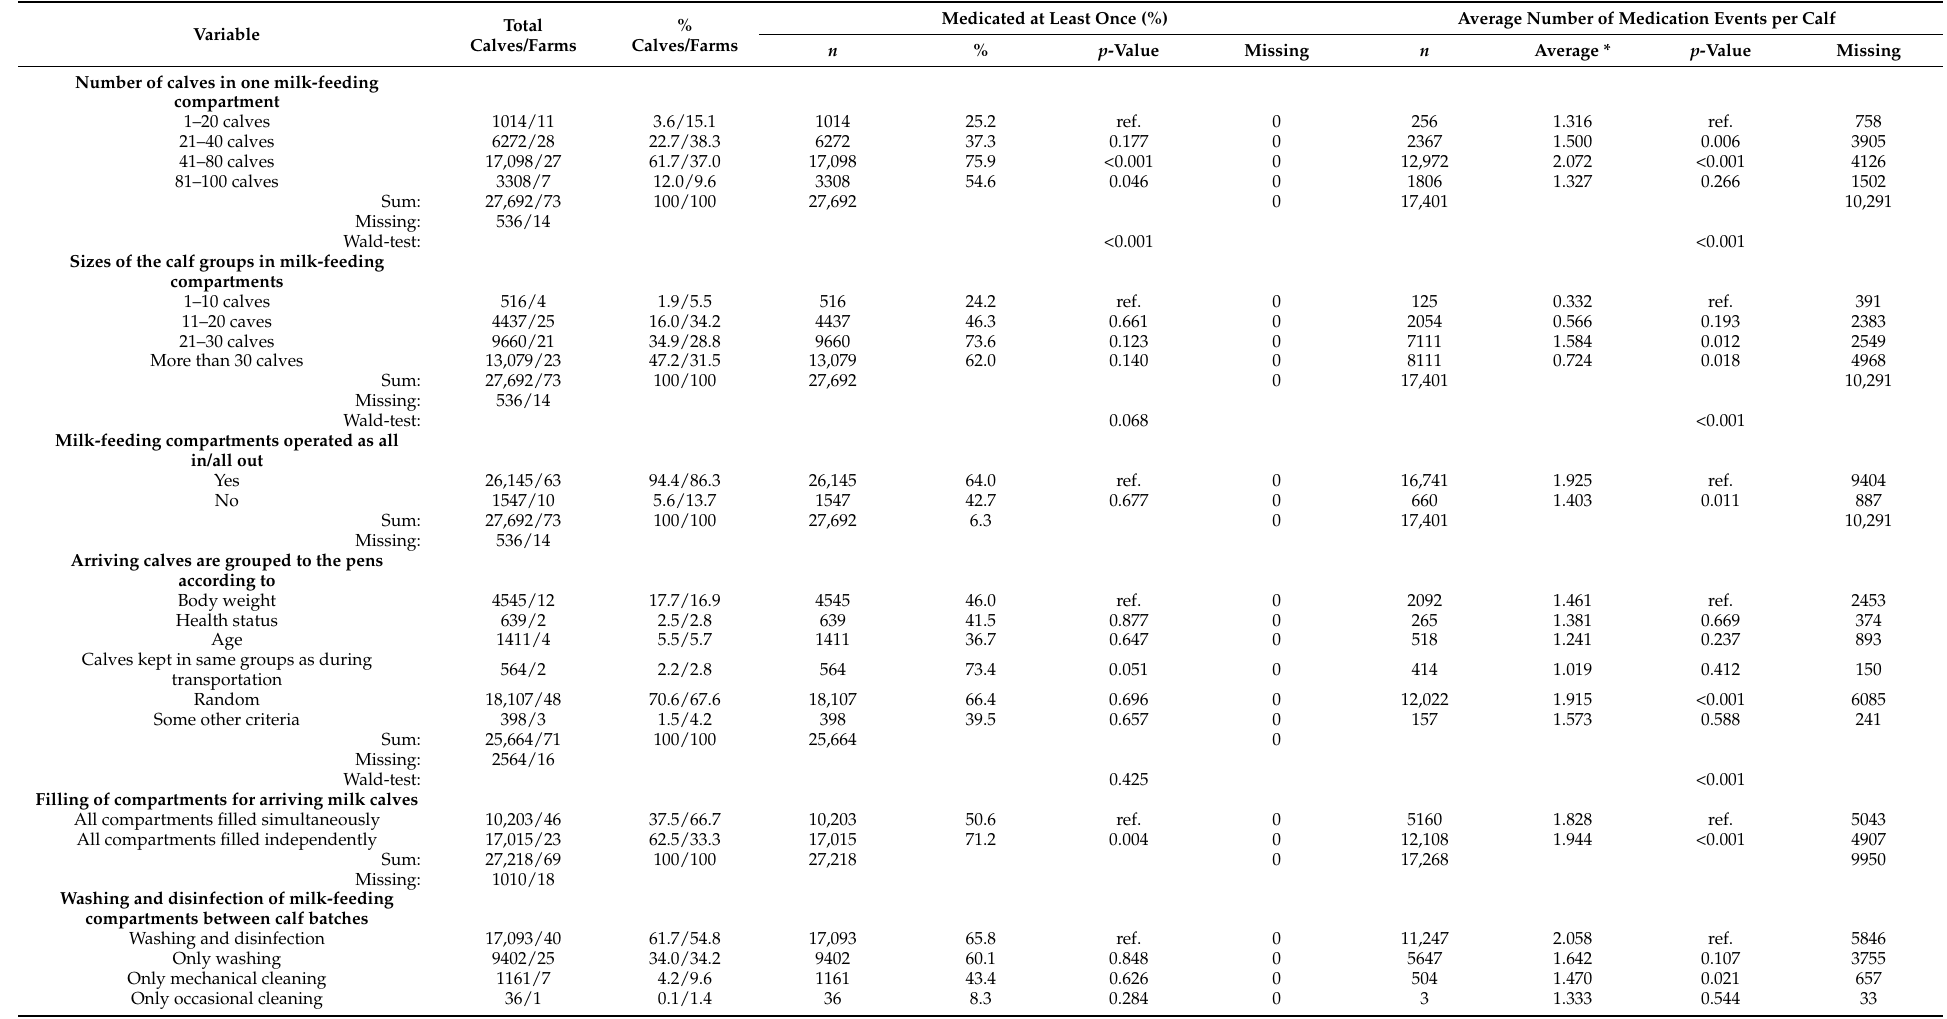
Table 3. Descriptive statistics of management and compartmentation data for 28,228 calves reared in calf rearing farms and univariate associations of predictor and outcome variables. Milk-feeding variables are only available for specialized calf rearing farms and fattening farms for milk